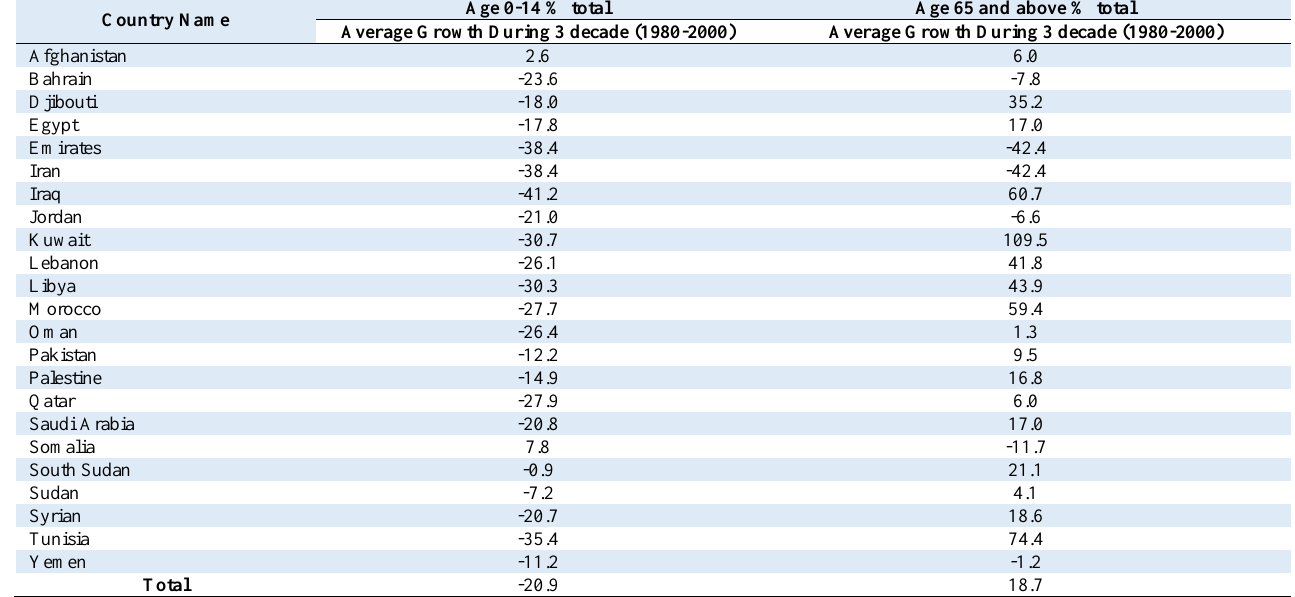
Table 2. Average percentage of growth in each age group in each country during